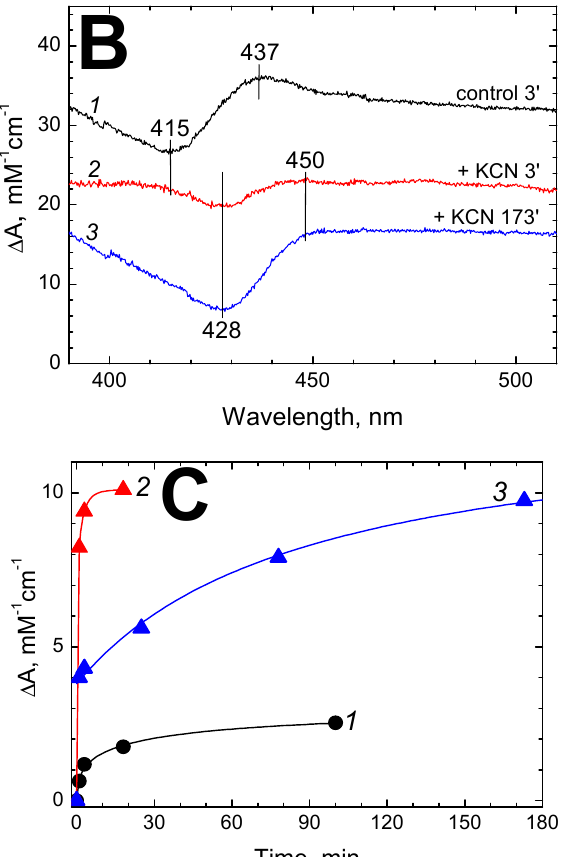
Figure 3. Estradiol-induced spectral changes of CcO. ( A ) Di ff erence spectra induced by addition of 0.5 mM ( 1–4 ) or 1 mM ( 5–7 ) estradiol benzoate to the air oxidized CcO (1.22 µ M). Spectra were recorded at the indicated time intervals after the hormone addition. The basic medium (pH 8.0) was supplemented with 13 mM DM. ( B ) E ff ect of cyanide on the estradiol-induced spectral shift of heme a 3 3 + . Spectrum 1 (black)—control (di ff erence spectrum recorded 3 min after addition of 1 mM estradiol to the air oxidized CcO). Spectrum 2 (red) was obtained as 1 but with the cyanide-complexed CcO (produced by 1 h incubation of CcO in the assay medium supplemented with 5 mM KCN and 25 µ M potassium ferricyanide which prevented oxidized cyanide adduct from slow reduction). Spectrum 3 (blue)—as 2 but recorded 3 h after estradiol addition. Other conditions are as in panel A. ( C ) Time dependence of the estradiol-induced spectral changes. Traces 1 (black circles) and 2 (red triangles) represent time evolution of absorption di ff erence at (437–415 nm) caused in the ligand-free oxidized CcO by incubation with 0.5 mM and 1 mM estradiol, respectively (see panel A). Trace 3 (blue triangles)—development of absorption di ff erence at (428–450 nm) induced in the cyanide-complexed CcO by incubation with 1 mM estradiol (see panel